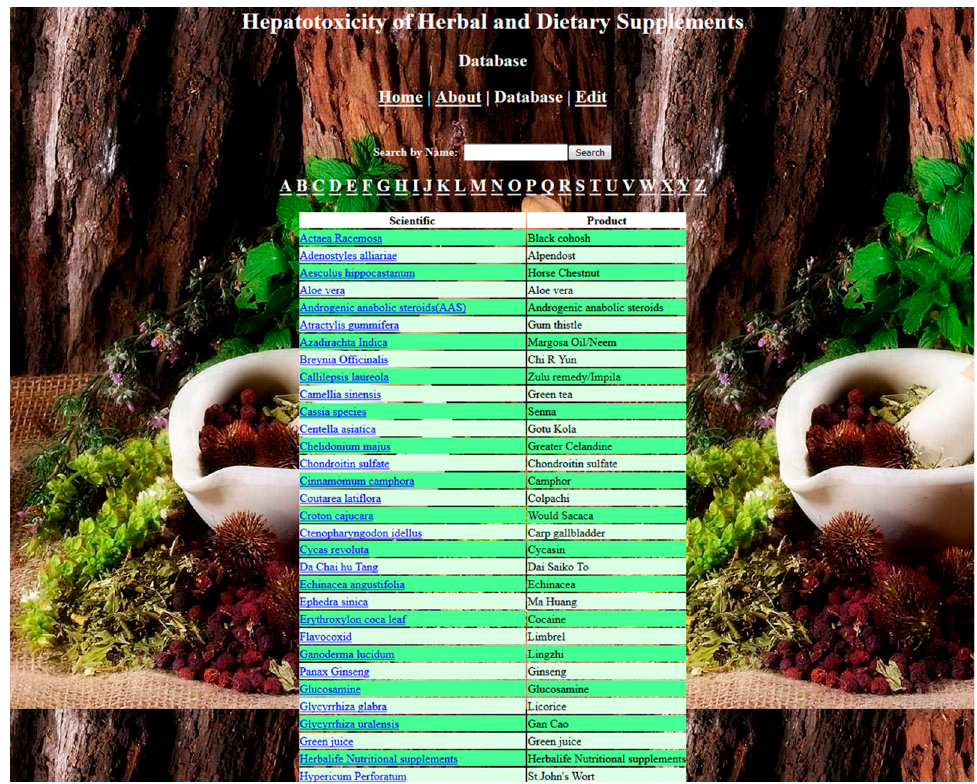
Figure 5. The screenshot of the Herbal and Dietary Supplements Hepatotoxicity Database (currently only for FDA